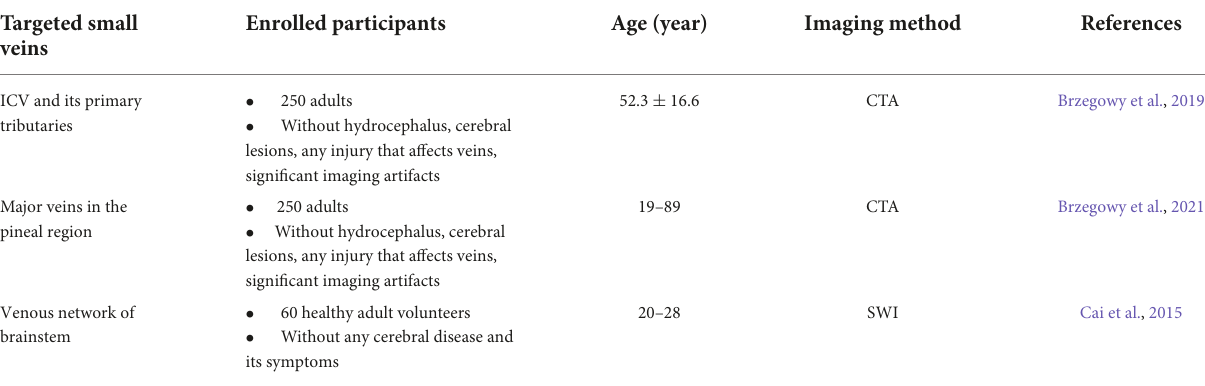
TABLE 2 Normal anatomy and variants of small cerebral veins accessed by various imaging